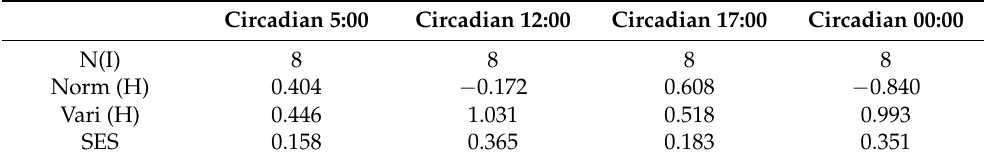
Table 7. Normalized entropy production from normal and abnormal (ice-based) day–night tempera- ture